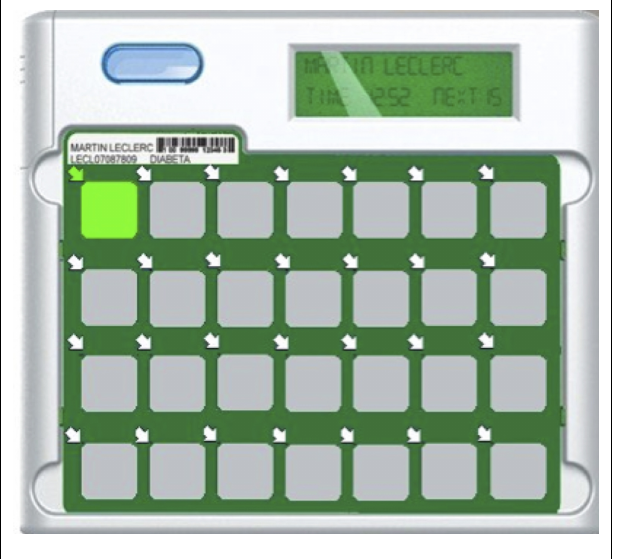
FIGURE 1 | DoPill ® – an intelligent electronic pill